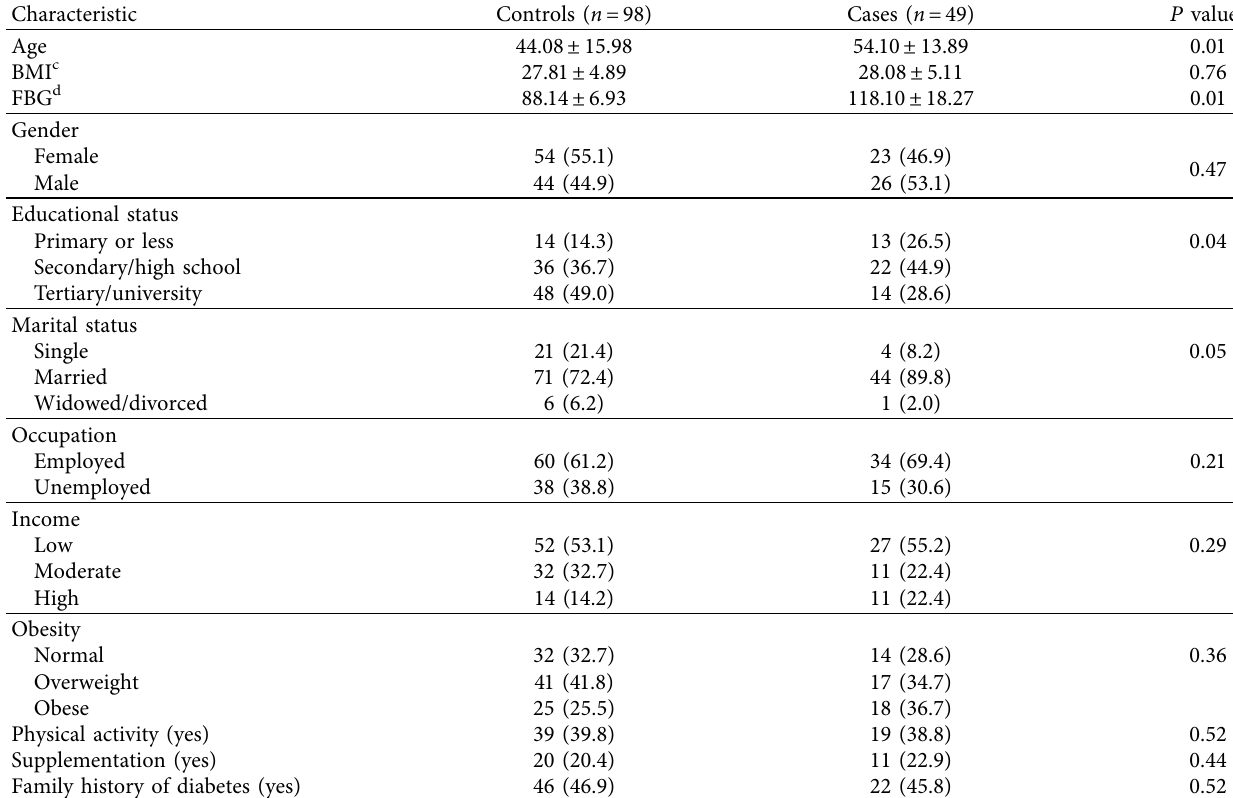
Table 1: Sociodemographic characteristics of participants a .